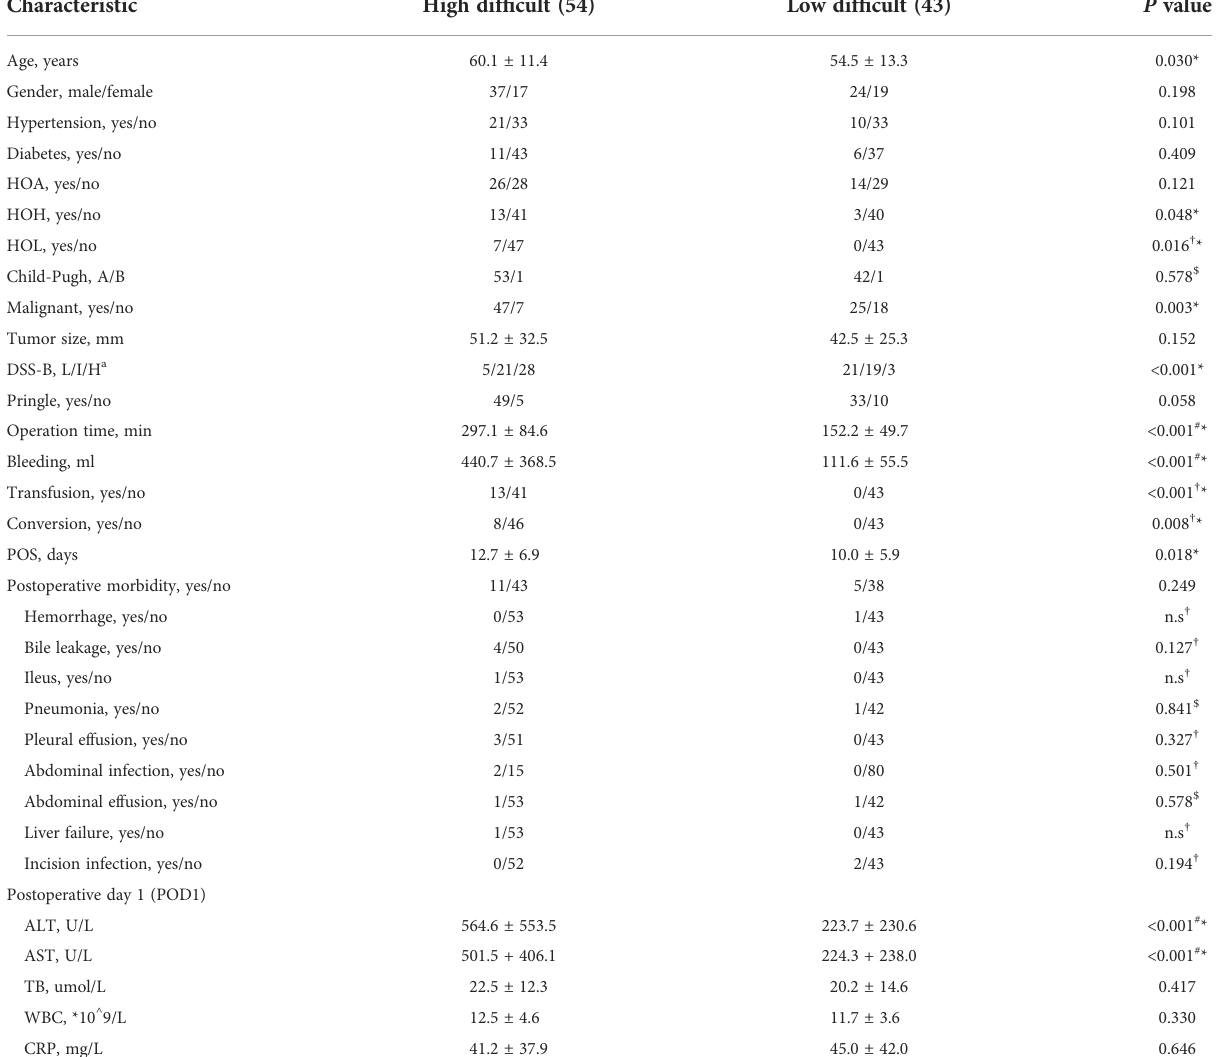
TABLE 2 Patient characteristics and surgical results of laparoscopic liver resection.